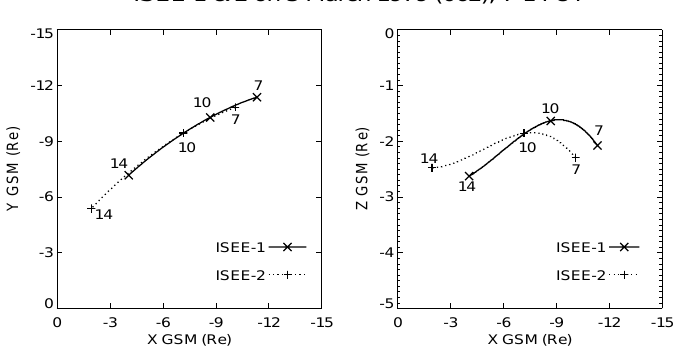
Fig. 3. Orbits of ISEE-1 and 2 projected onto the GSM XY plane (left panel) and XZ plane (right panel) during the time period of 07:00 to 14:00 UT on 3 March 1979 (day 062).